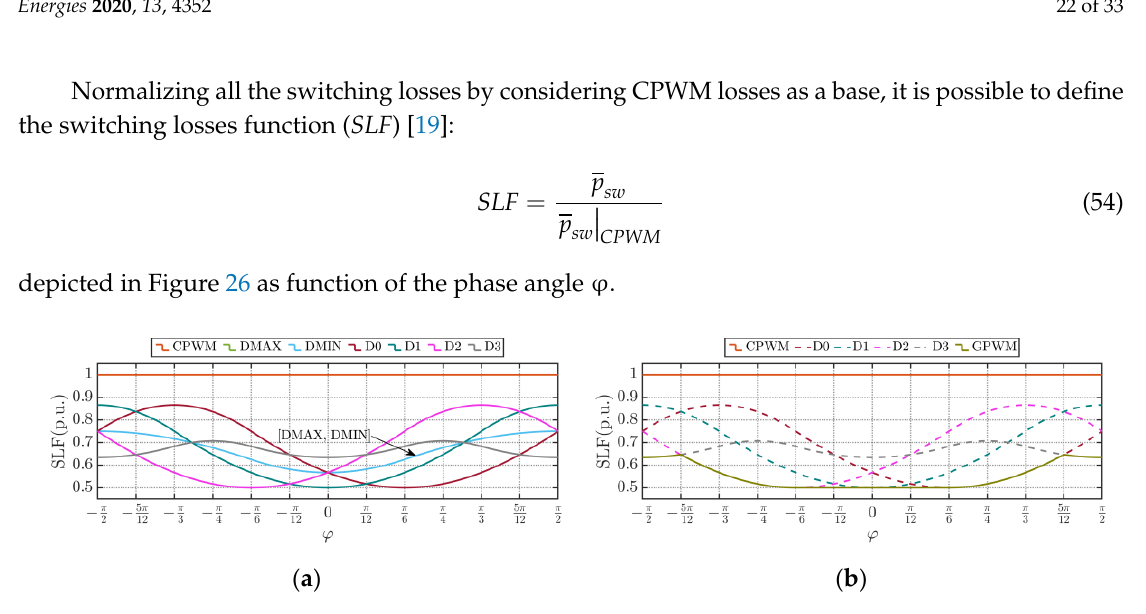
Figure 26. Switching loss function in case of: ( a ) CPWM, DPWMMAX, DPWMMIN, DPWM0, DPWM1, DPWM2, and DPWM3; ( b ) Switching loss function in case of optimized GDPWM.